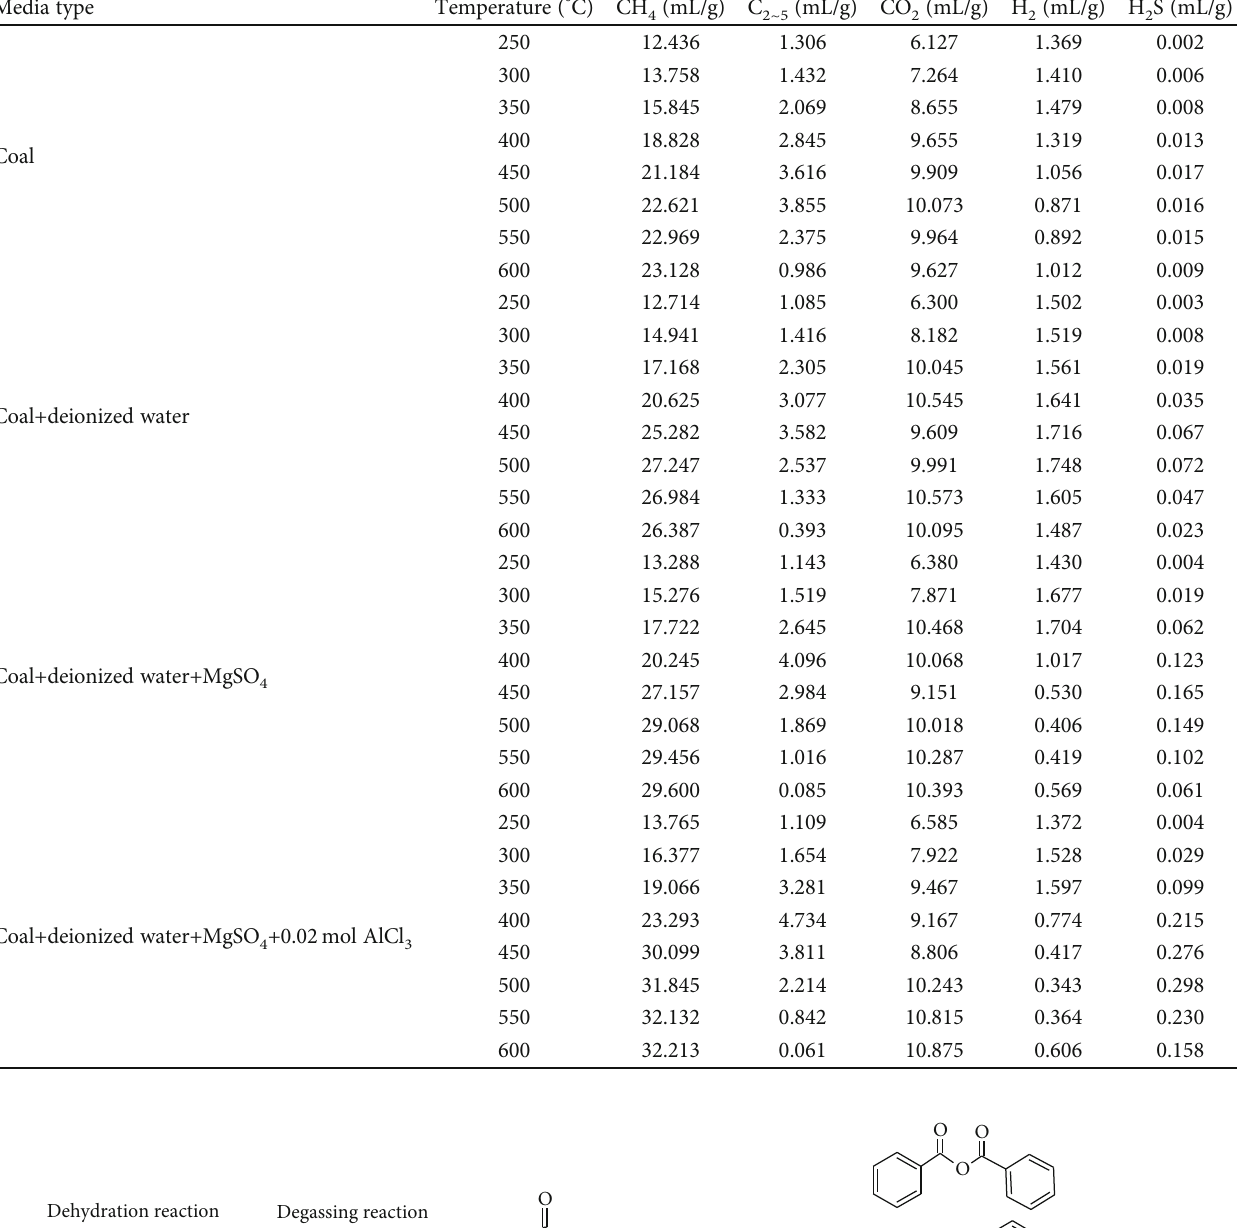
Table 2: Test results of gaseous products.